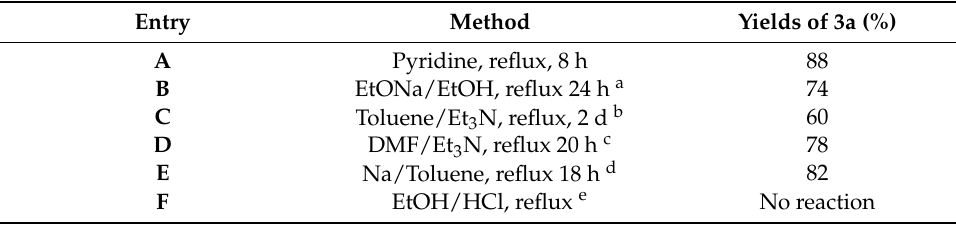
Table 1. The reaction optimization for the formation of 3a.